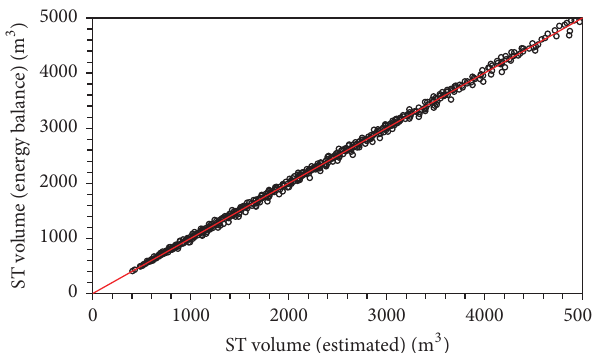
Figure 3: Estimated ST volume versus the volume calculated by the energy balance.